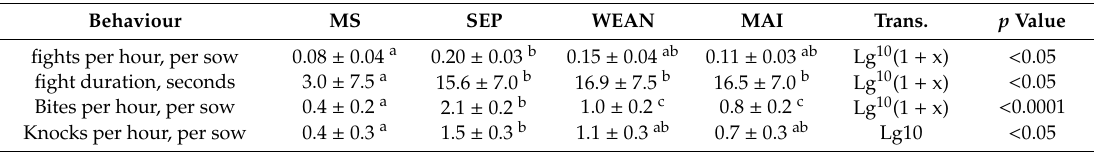
Table 4. Effect of treatment on gestating sows on measures of aggression delivered per hour in the days after mixing 1,2 .